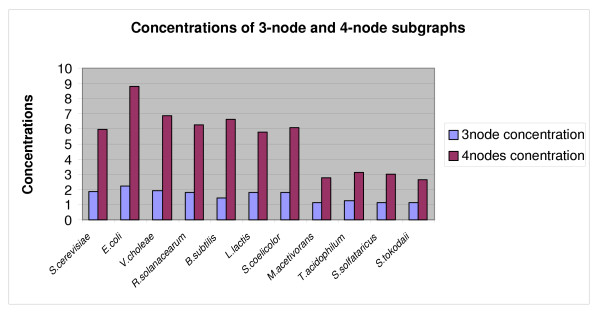
Concentrations (number of appearances divided by number of nodes with edges/arcs) of three-node and four-node subgraphs.